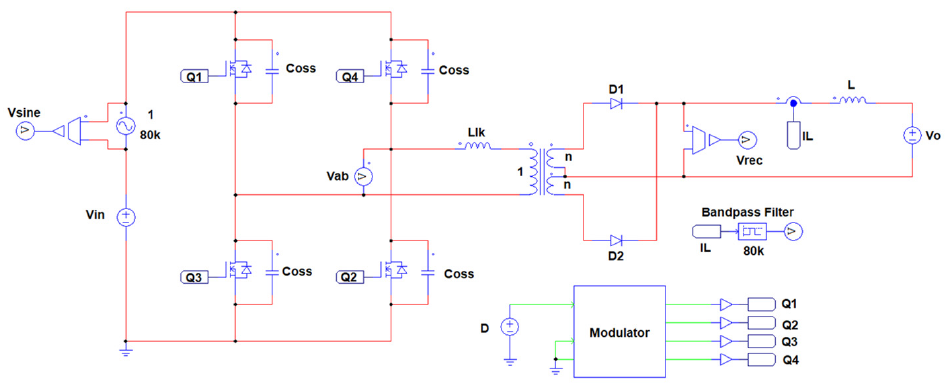
Figure 6. PSIM schematic of the PSFB converter in which a sinusoidal perturbation is injected into the input voltage.